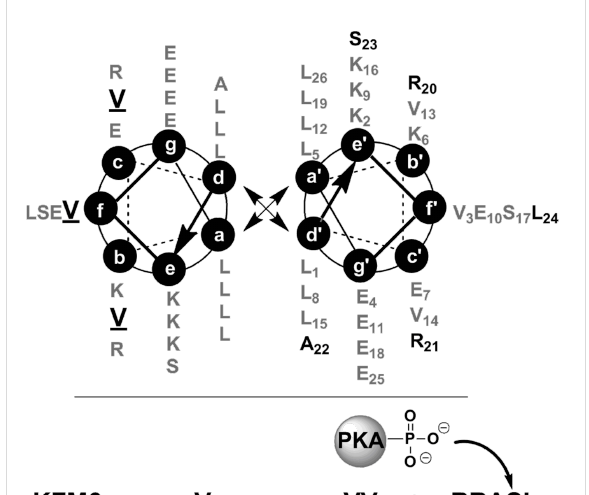
Scheme 1: Helical wheel projection of two parallel helical strands and primary structure of KFM6. The recognition motif KFM6(20–24) for PKA is given in bold and valine residues are bold and